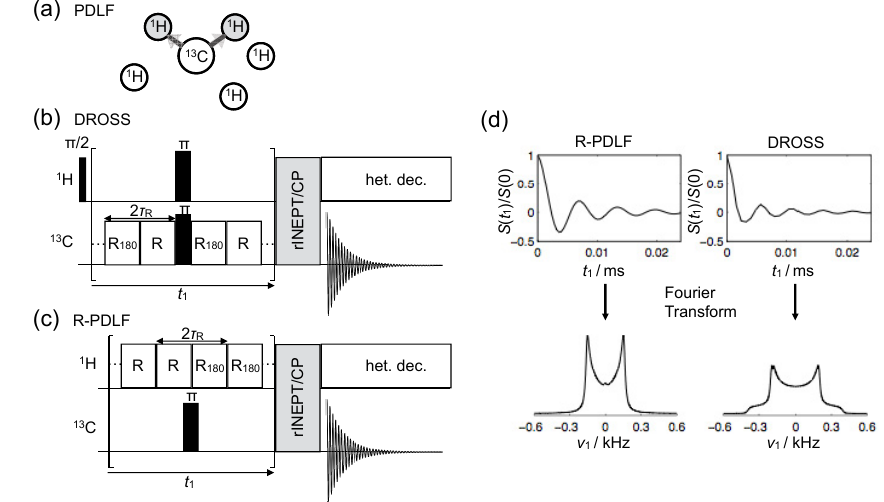
Figure 13. Proton-detected local field NMR. ( a ) Basic mechanism where the heteronuclear dipolar coupling is recoupled, modulating the proton magnetization which is then transferred to carbon; ( b ) The Dipolar Recoupling On-axis with Scaling and Shape preservation (DROSS) pulse sequence and ( c ) the R-PDLF pulse sequence; ( d ) Simulations of corresponding results using the SIMPSON software [89] for a heteronuclear dipolar coupling of 1